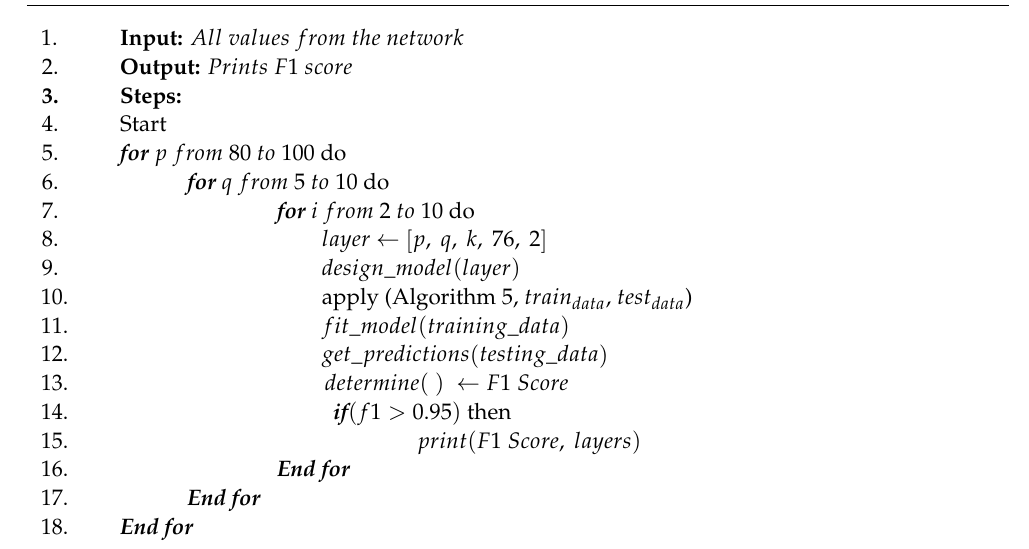
Algorithm 4: Layers determination using Brute Force